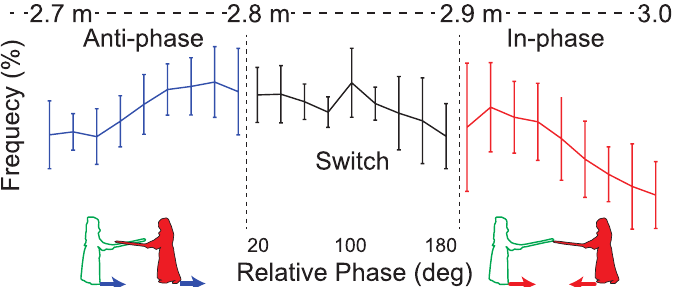
Figure 1. Abrupt changes in the interpersonal coordination pattern corresponding to an interpersonal distance of 2.7–3.0 m while playing kendo. The frequencies of the relative phase per 0.1 m interval at interpersonal distances of 2.7–3.0 m were calculated, and the means and standard deviations are presented. The relative phases were divided into nine ranges (0 ◦ –20 ◦ , 20 ◦ –40 ◦ , 40 ◦ –60 ◦ , 60 ◦ –80 ◦ , 80 ◦ –100 ◦ , 100 ◦ –120 ◦ , 120 ◦ –140 ◦ , 140 ◦ –160 ◦ , and 160 ◦ –180 ◦ ). Anti-phase coordination was dominant at interpersonal distances of 2.7–2.8 m. However, in-phase coordination was dominant at interpersonal distances of 2.9–3.0 m. Modified from